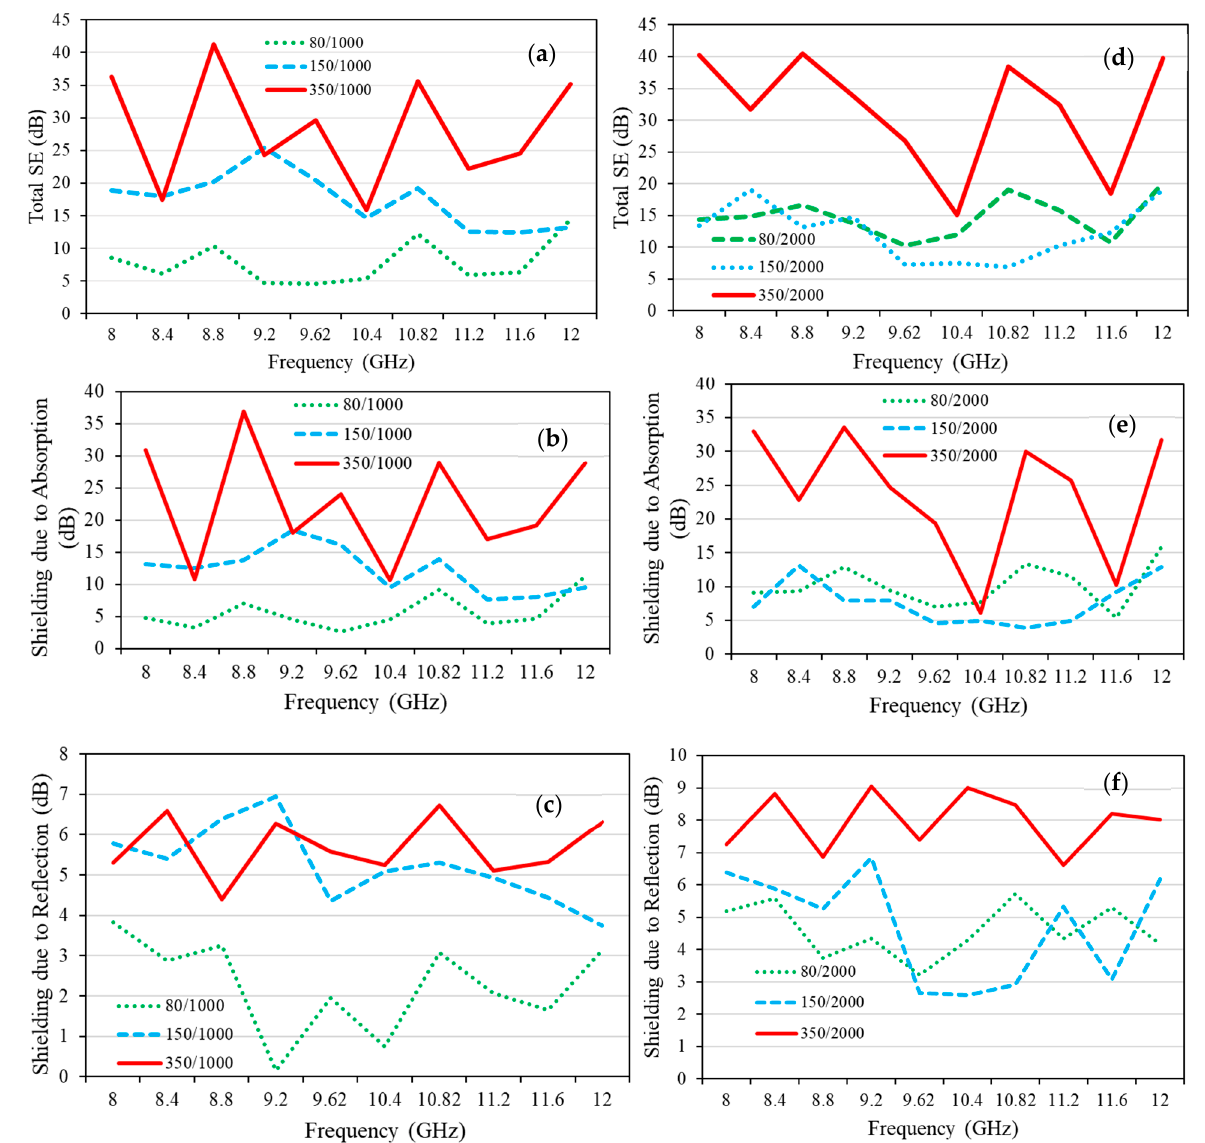
Figure 4. Shielding effectiveness of composites with Fe 3 O 4 nano particles of 0.5 wt.% and carbon fibers with fiber density of 1000 fibers/mm 2 ( a ) total SE, ( b ) absorption SE, and ( c ) reflection SE; carbon fibers with fiber density of 2000 fibers/mm 2 ( d ) total SE, ( e ) absorption SE, and ( f ) reflection SE.